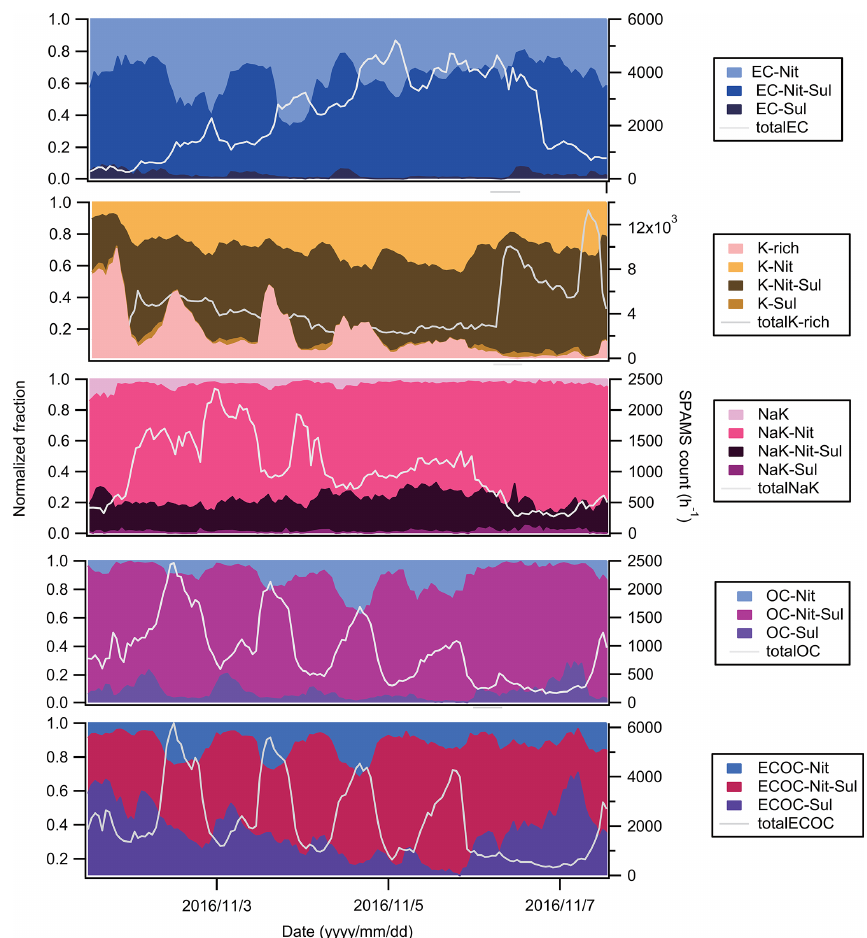
Figure 6. Time trends of number fractions of particle types (left) and hourly counts of particle families (EC, BB, NaK, OC, and ECOC; right) during Pollution Event 1 (E1; 1–8 November) at